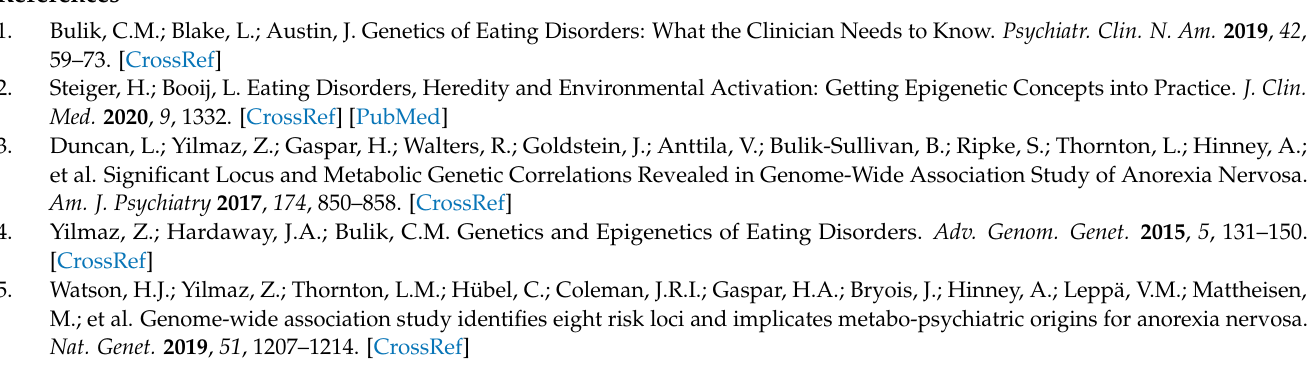
size, Table S2: Descriptive statistics of comethylation modules’ beta values, Table S3: Functional en- richments of comethylation modules, Table S4: Characteristics of SNPs correlated with comethylation